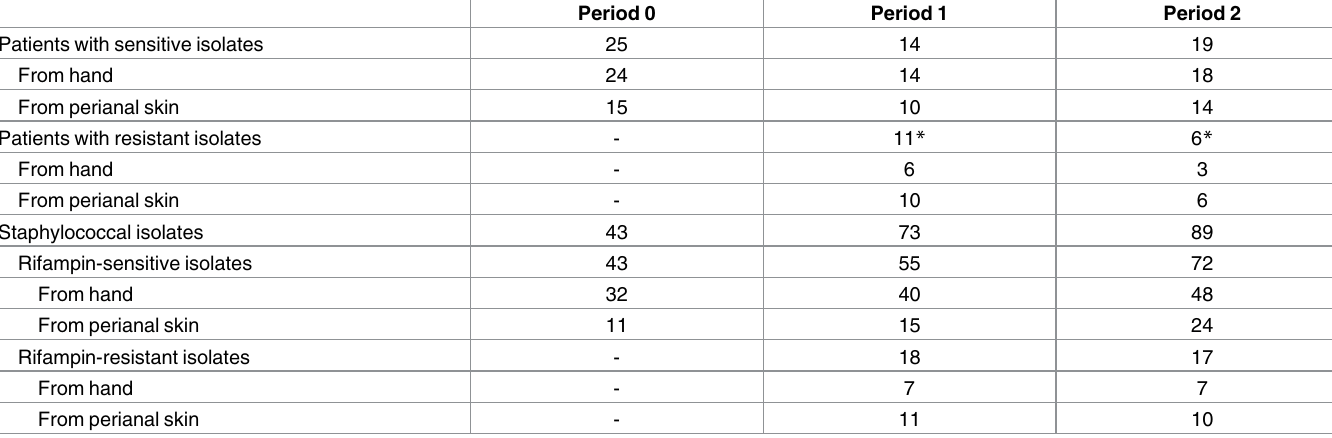
Table 3. Incidence of staphylococcal isolates during the